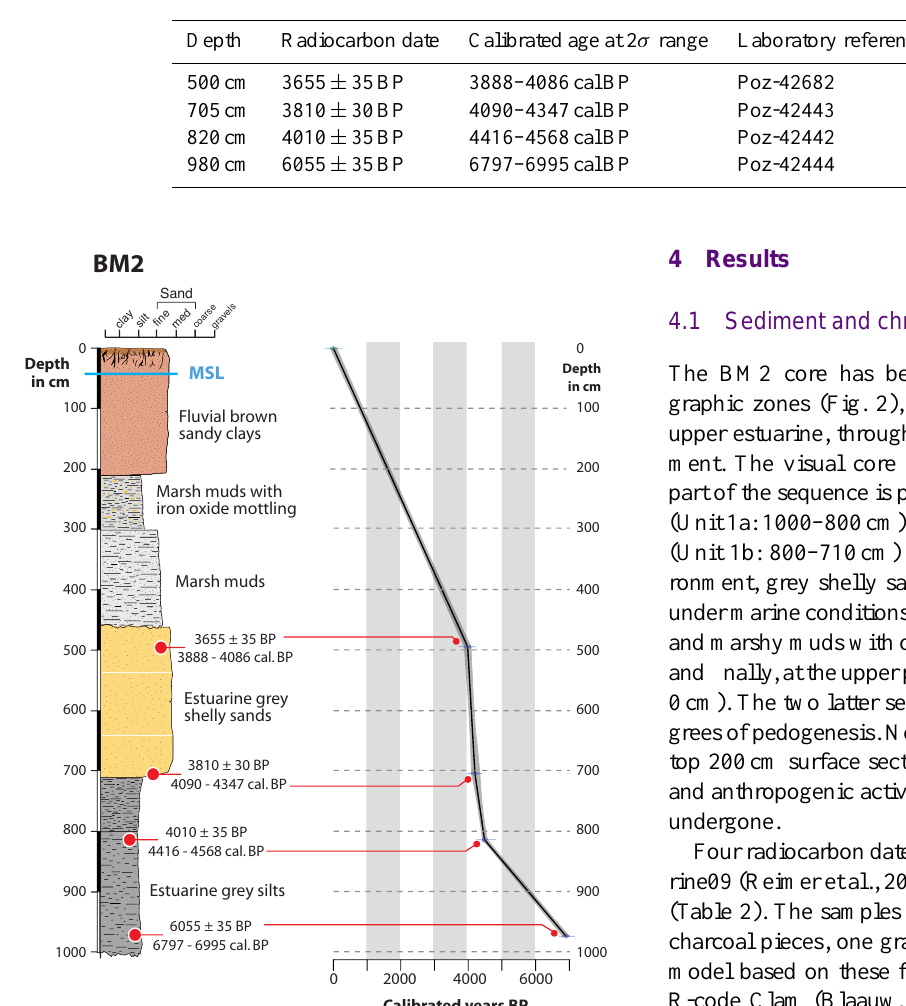
Table 2. Radiocarbon dates obtained from the Burmarrad BM2 core.